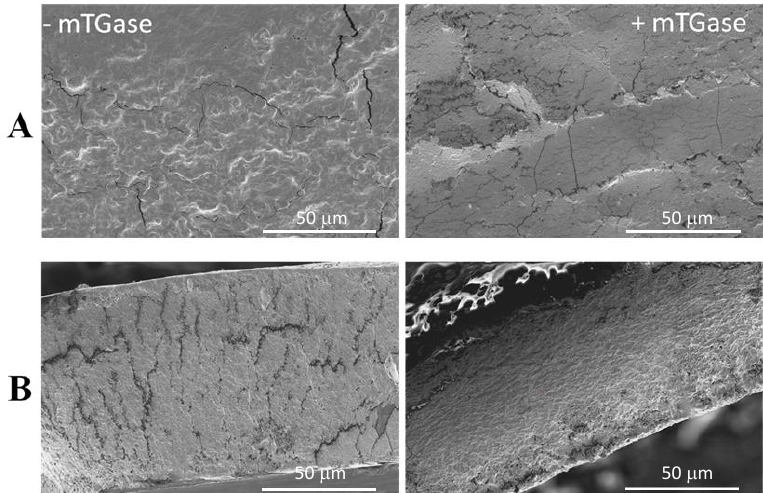
Figure 3. SEM micrographs of surface ( A ) and cross-sections ( B ) at 2600 × magnification of grass pea flour-based films prepared in the absence and the presence of mTGase.